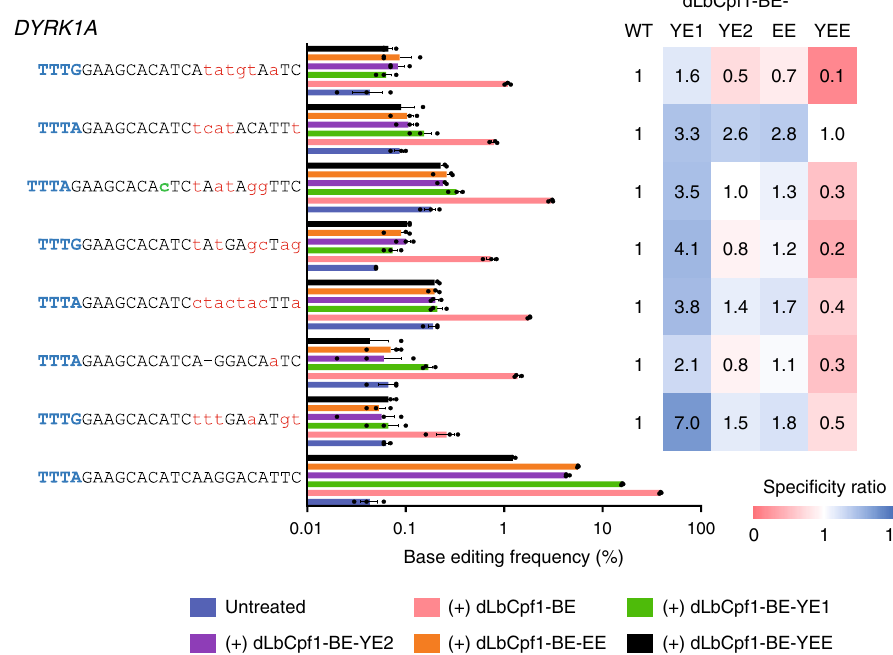
Fig. 4 Reducing dLbCpf1-BE off-target effects by incorporating mutations in the APOBEC1 domain. Plasmids encoding versions of dLbCpf1-BE containing mutations in the APOBEC1 domain (YE1: W90Y + R126E; YE2: W90Y + R132E; EE: R126E + R132E; YEE: W90Y + R126E + R132E) were transfected into HEK293T cells to determine if these mutations would improve base editing speci fi city. Base editing frequencies at on- and -off target sites were determined by targeted deep sequencing. The speci fi city ratios were calculated by dividing (base editing frequency of dLbCpf1-BE variants at on-target/that at off- target) by (base editing frequency of dLbCpf1-BE-WT at on-target/that at off-target). Mismatched bases and PAM sequences are shown in red and blue, respectively. An RNA bulge is represented as a dash and a DNA bulge is shown in green. Data are shown as mean ± s.e.m. from three biologically independent samples. Source data are provided as a Source Data fi